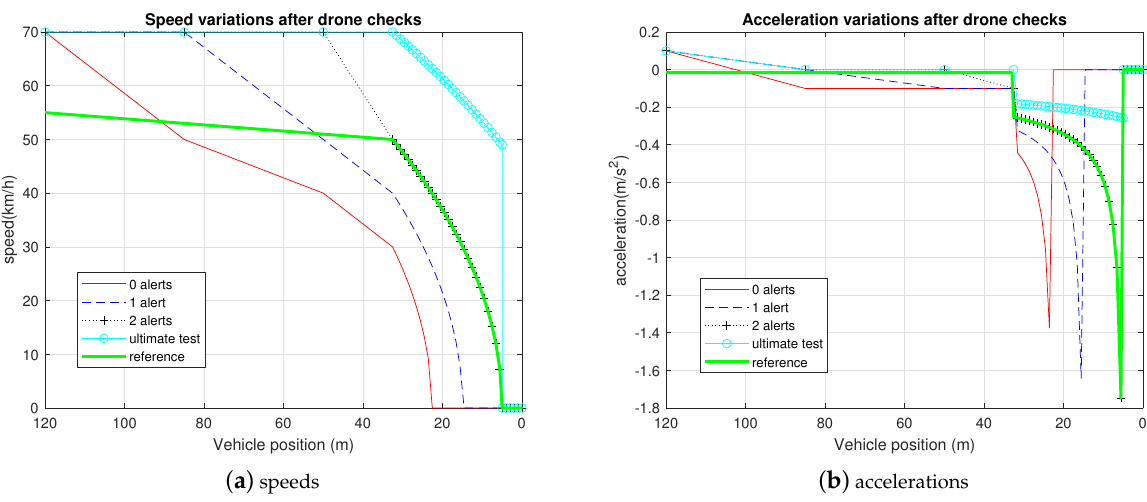
Figure 11. Speeds and accelerations of driver type 2, case of dry curved